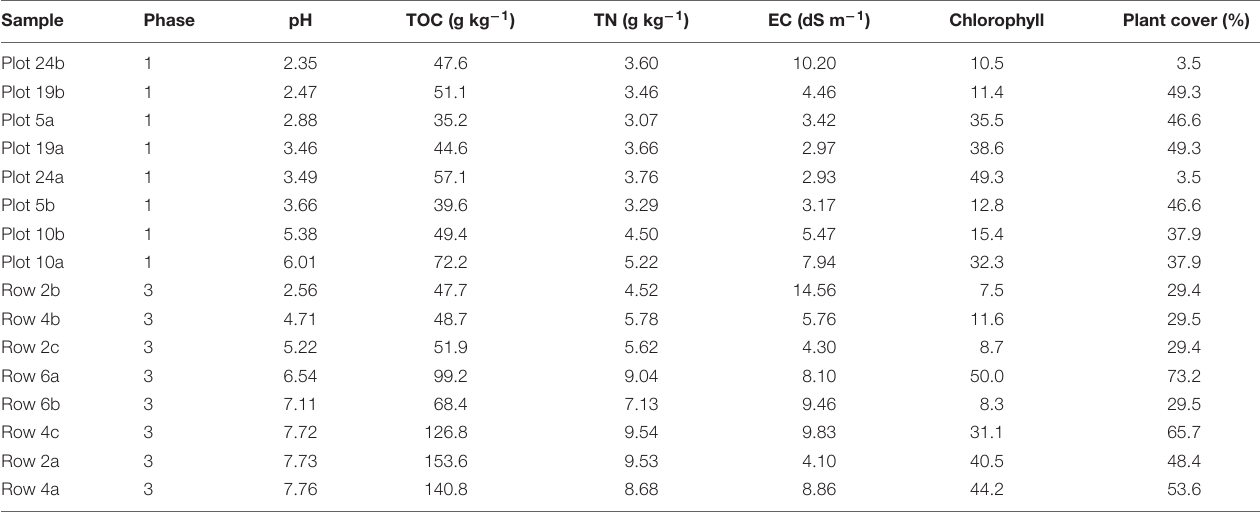
TABLE 1 | Geochemical and plant condition parameters for tailings substrate collected next to each buffalo grass plant.